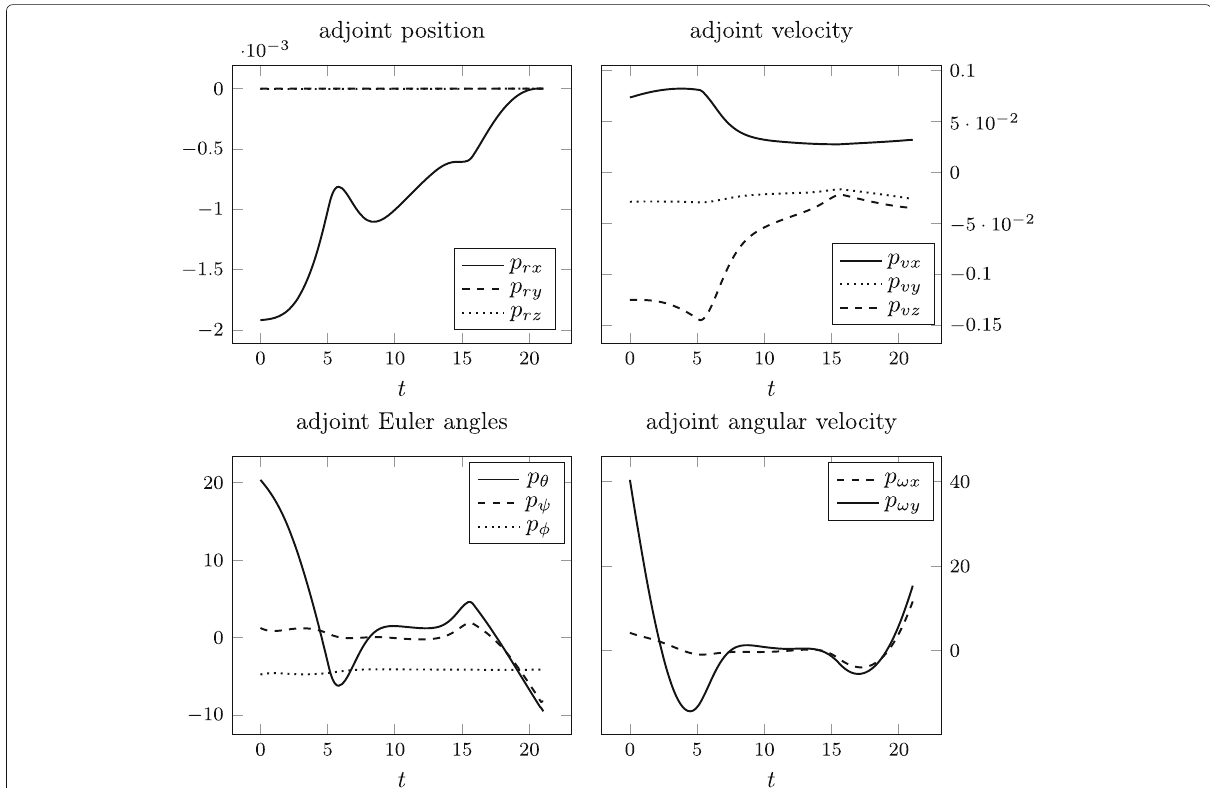
Fig. 19 Time history of the adjoint variable p ( t ) during the pull-up